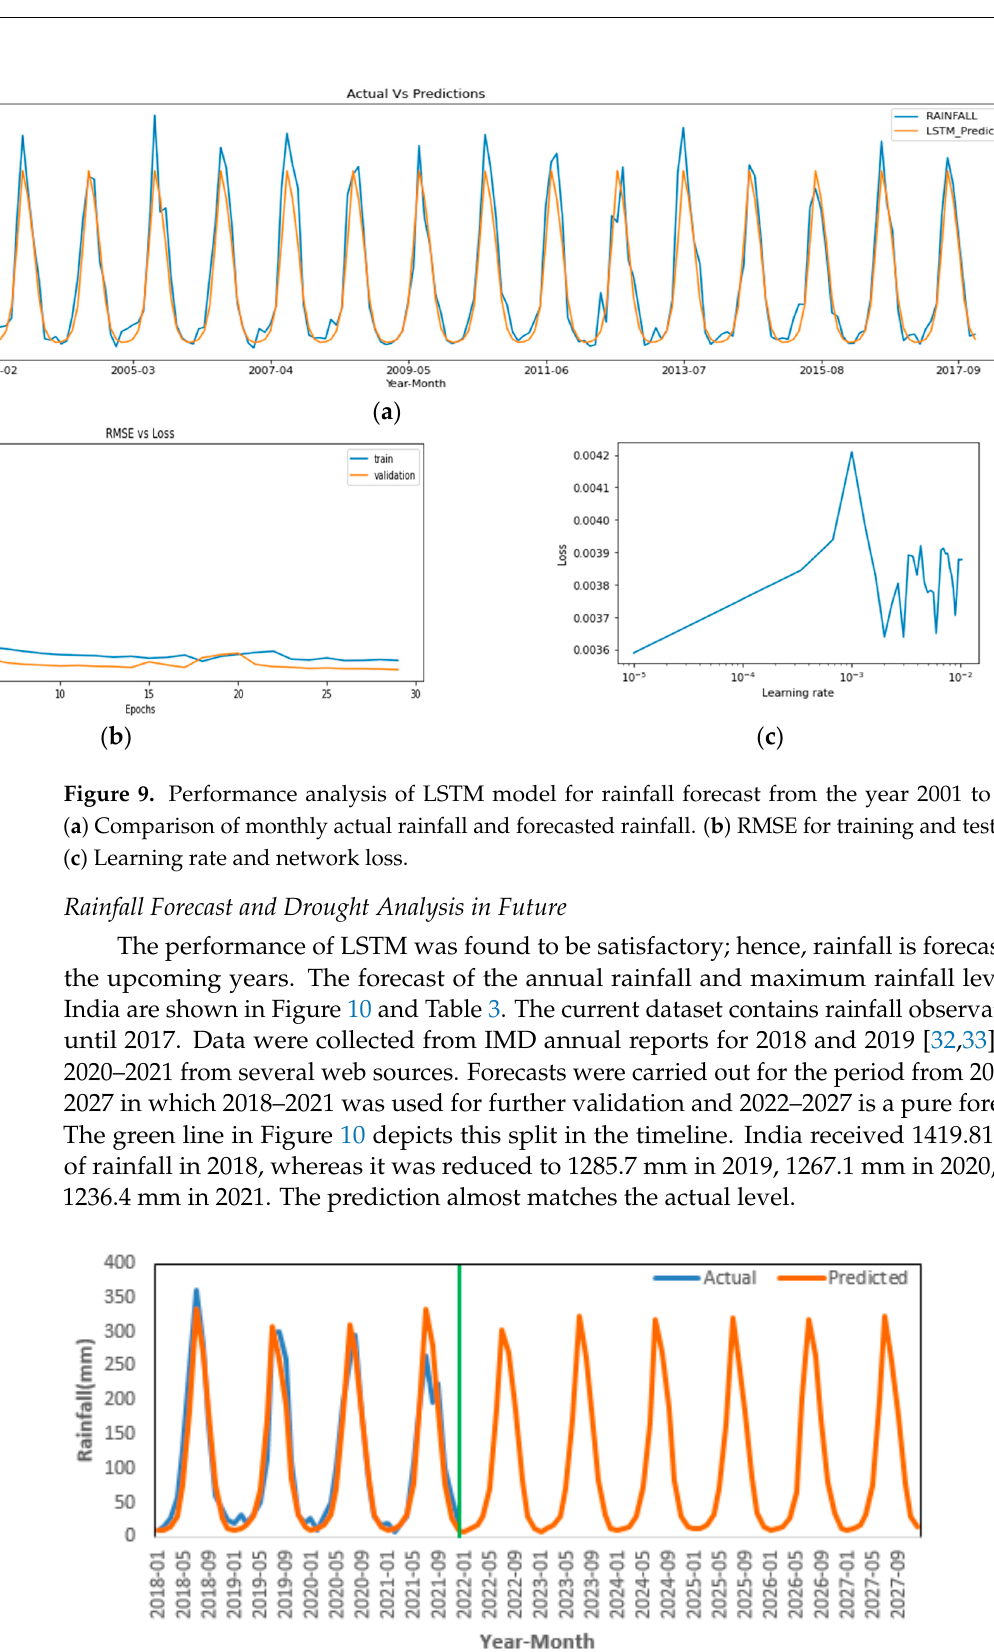
Figure 10. Rainfall forecast for forthcoming years 2022–2027 (green line splits the validation and forecast period).